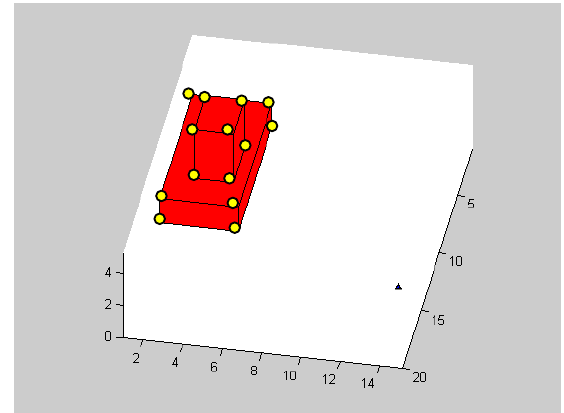
Figure 2. Modeling Car Using 3D Boxes (CBP Marked with Yellow